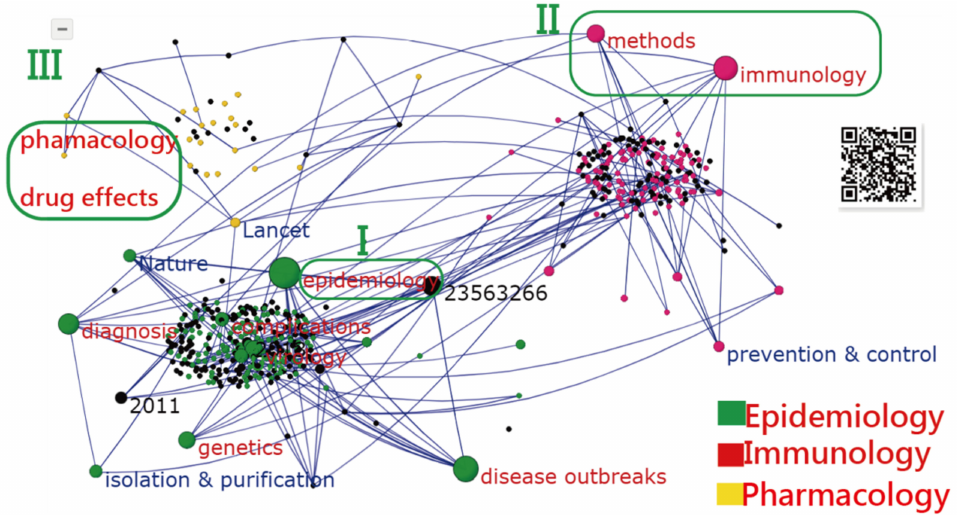
Figure 5. The most cited countries/areas and articles on the topic of dengue; three clusters are separated in the network, and the bubble sizes of the articles’ citations and centrality degree in SNA based on the top-cited articles with at least 100 citations (T100DO) articles.